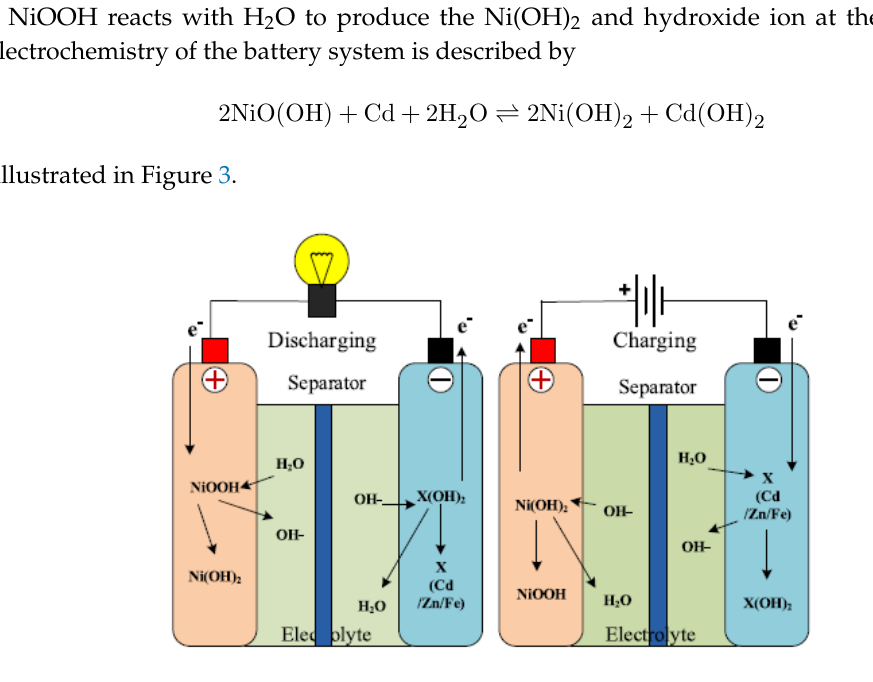
Figure 3. Charge/discharge operation of NiCd battery